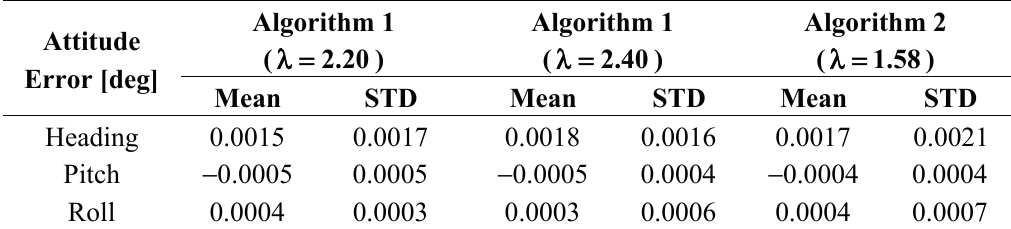
Table 14. Statistics for the results of the lab experiment.